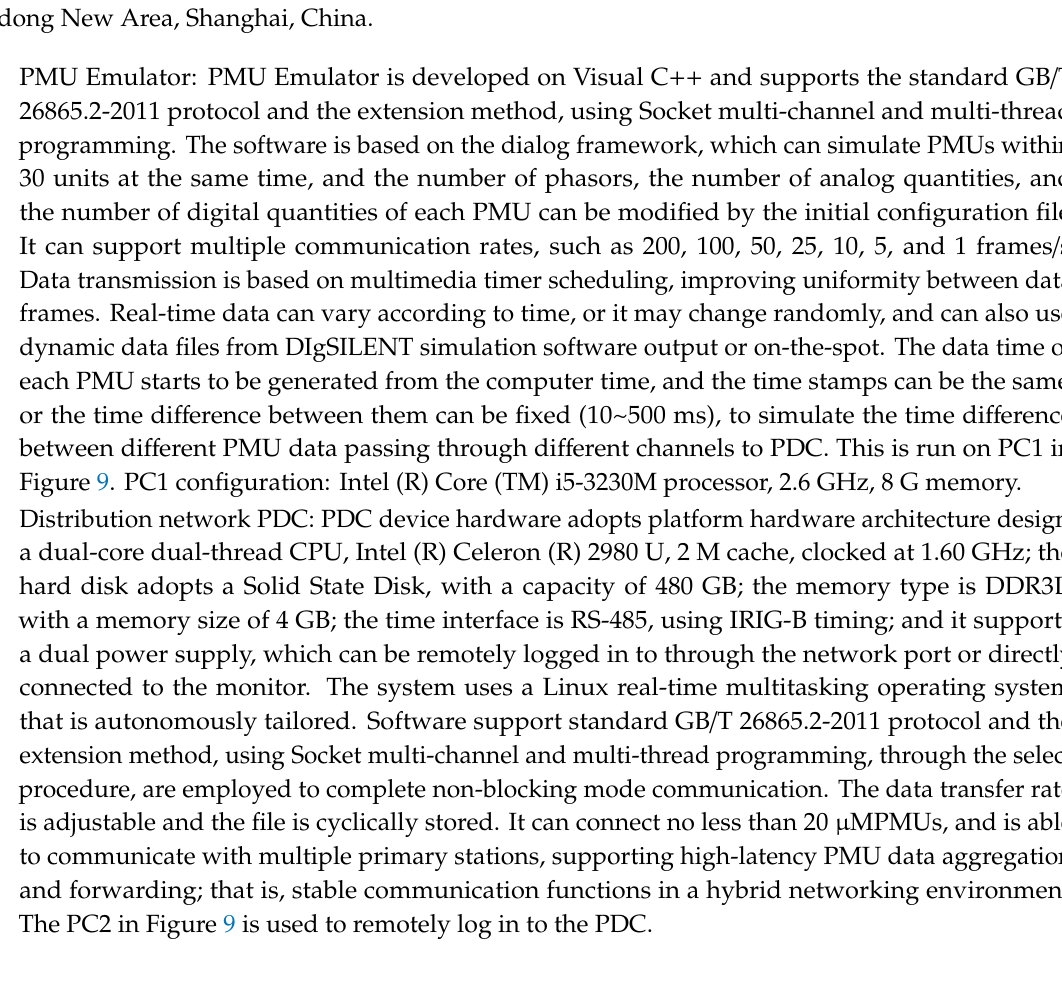
Figure 9. PC1 configuration: Intel (R) Core (TM) i5-3230M processor, 2.6 GHz, 8 G